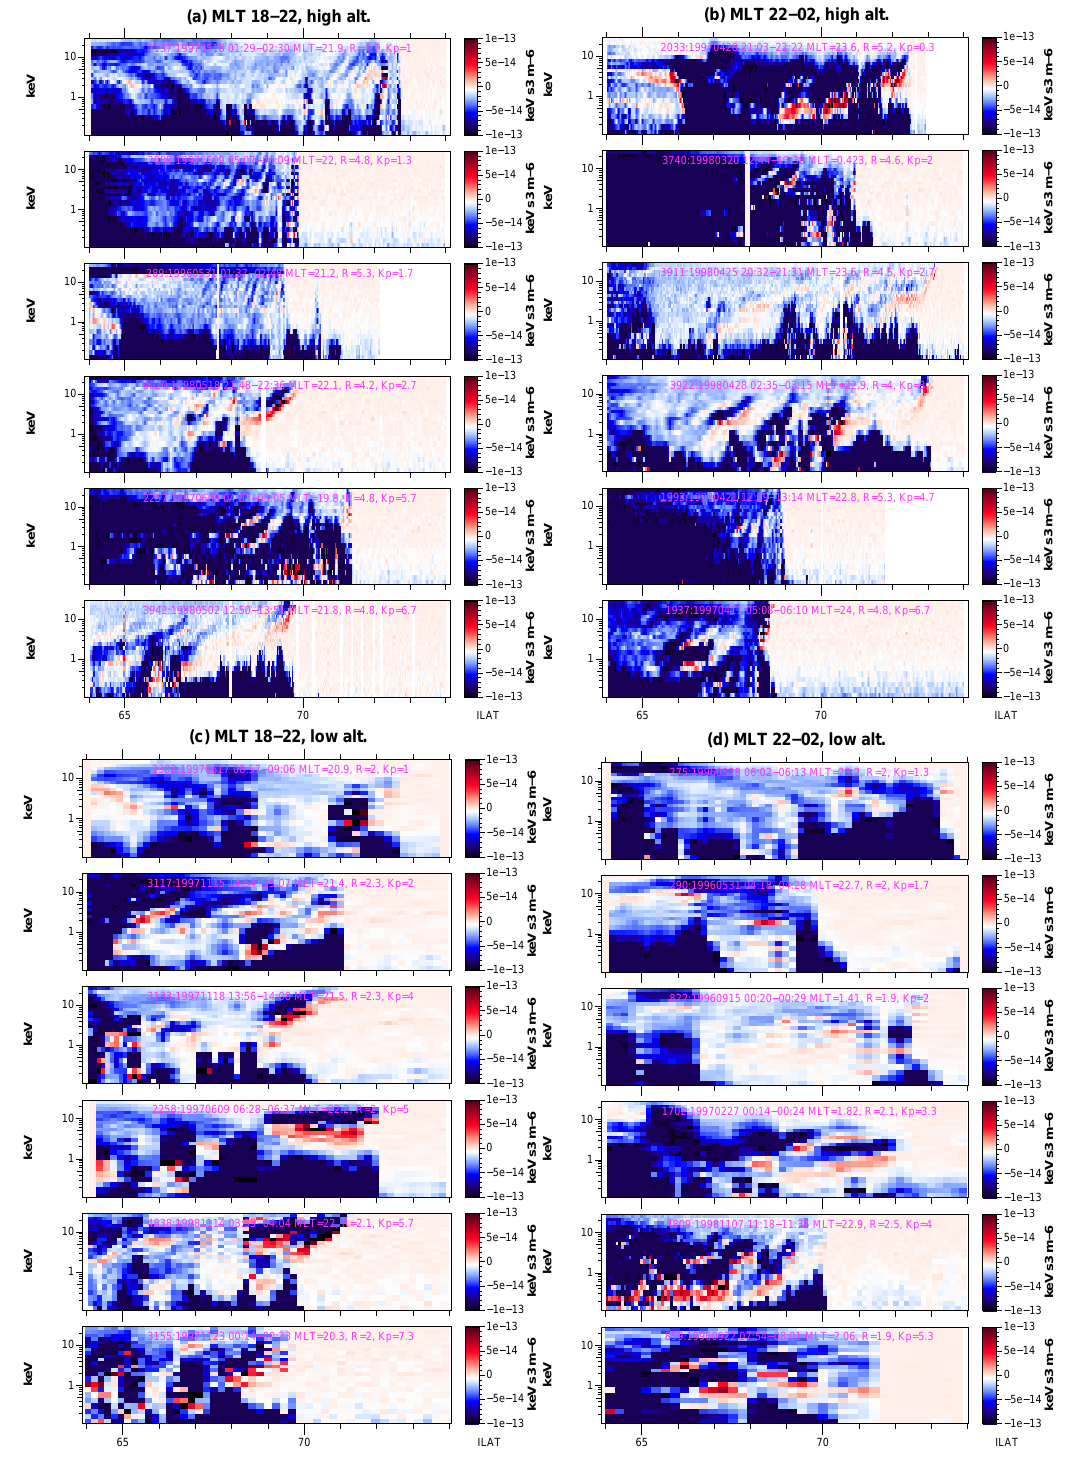
Fig. 1. Examples of multiple ion beamlets by Polar/Timas as a function of energy and ILAT for varying altitude, K p and MLT conditions. The quantity shown is S(E) , Eq. 1, in linear scale. Each subplot shows six panels with ion beamlets occurring during varying K p index, with increasing K p values from top to bottom panel. Top plots show ion beamlets for radial distances > 4 R E , and bottom plots for altitudes ≤ 2 . 5 R E . Left subplots show the ion beamlets for 18–22 MLT and right subplot for 22–02 MLT. Subplot a ) thus shows examples of ion beamlets for 18–22 MLT at high altitudes, and subplot b ) shows ion beamlets for high altitude but 22–02 MLT. The bottom subplots c ) give example for ion beamlets at low altitudes for 18–22 MLT and d ) for low altitudes and 22–02